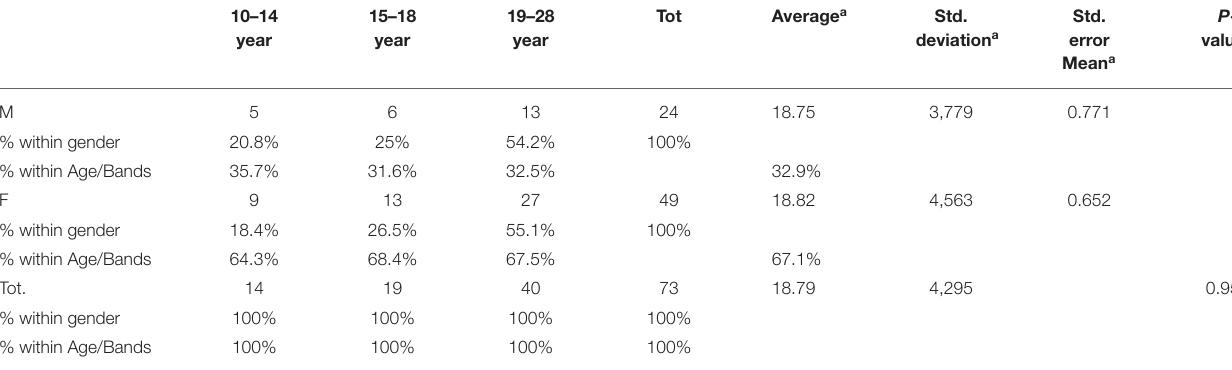
TABLE 2 | Age and gender distribution of the study